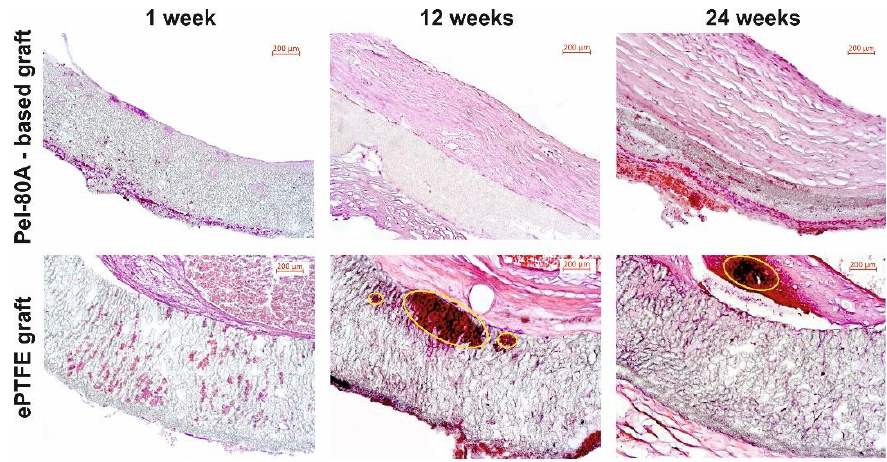
Figure 6. Hematoxylin and eosin images of studied VGs at different times after implantation (lumen of graft appears in the top right). The areas of calcification were indicated by yellow ovals. Scale bar is 200 μm.